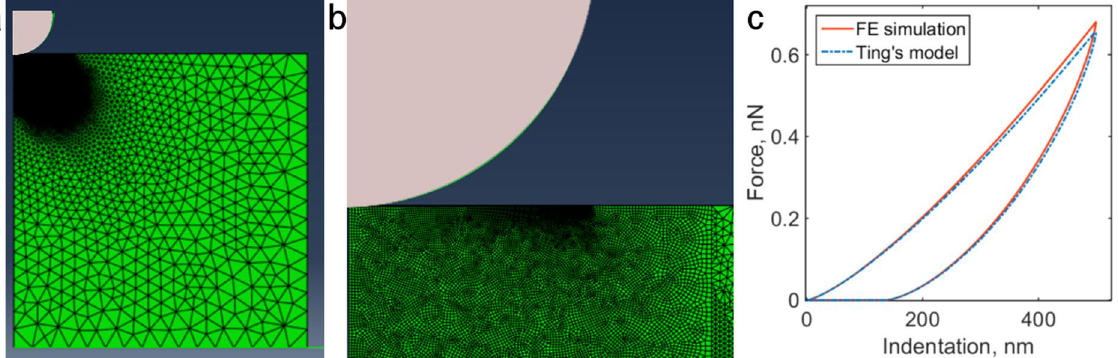
Figure 2. Validation of the developed algorithms with FE simulations. ( a ) Axisymmetric FE model, consisting of the rigid spherical indenter with 2 μ m radius and viscoelastic sample with 15 μ m height and radius. ( b ) Magnified view of the contact area, there the sample was meshed more finely. ( c ) Result of FE simulation and the F- δ curve modelled using Ting’s model with the same input parameters (SLS model with E 0 = 2 kPa, E ∞ = 1 kPa, and τ = 0.1